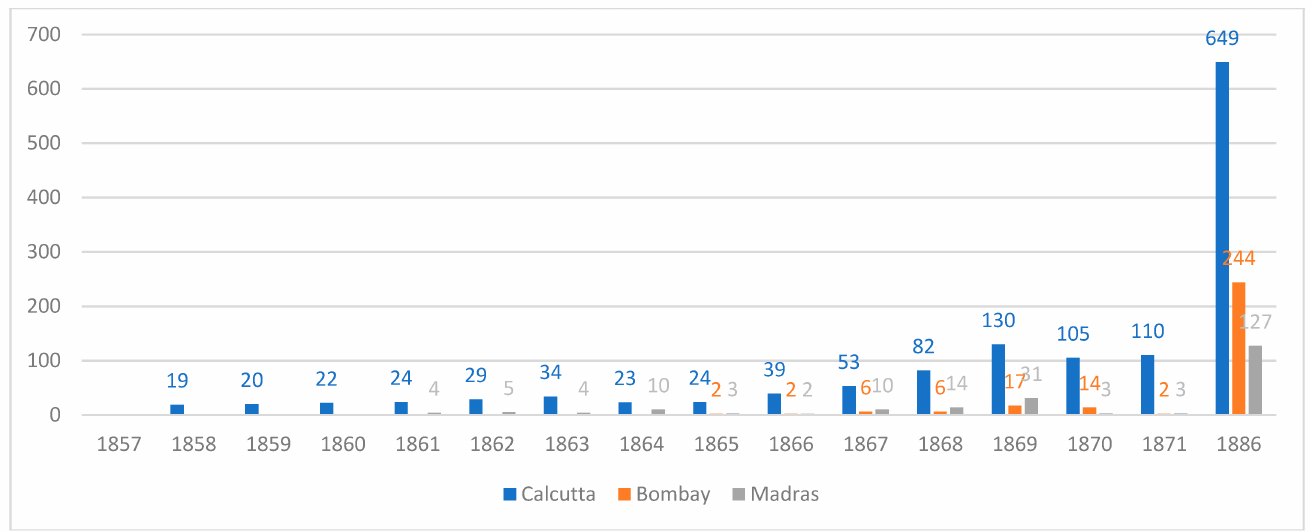
Figure 1. Total of students enrolled in law examinations in Indian universities, 1857–1871. This figure presents the total number of students taking the examinations for the degrees of Bachelor and Honors in Laws at the Universities of Calcutta, Bombay and Madras, from 1857 to 1871.